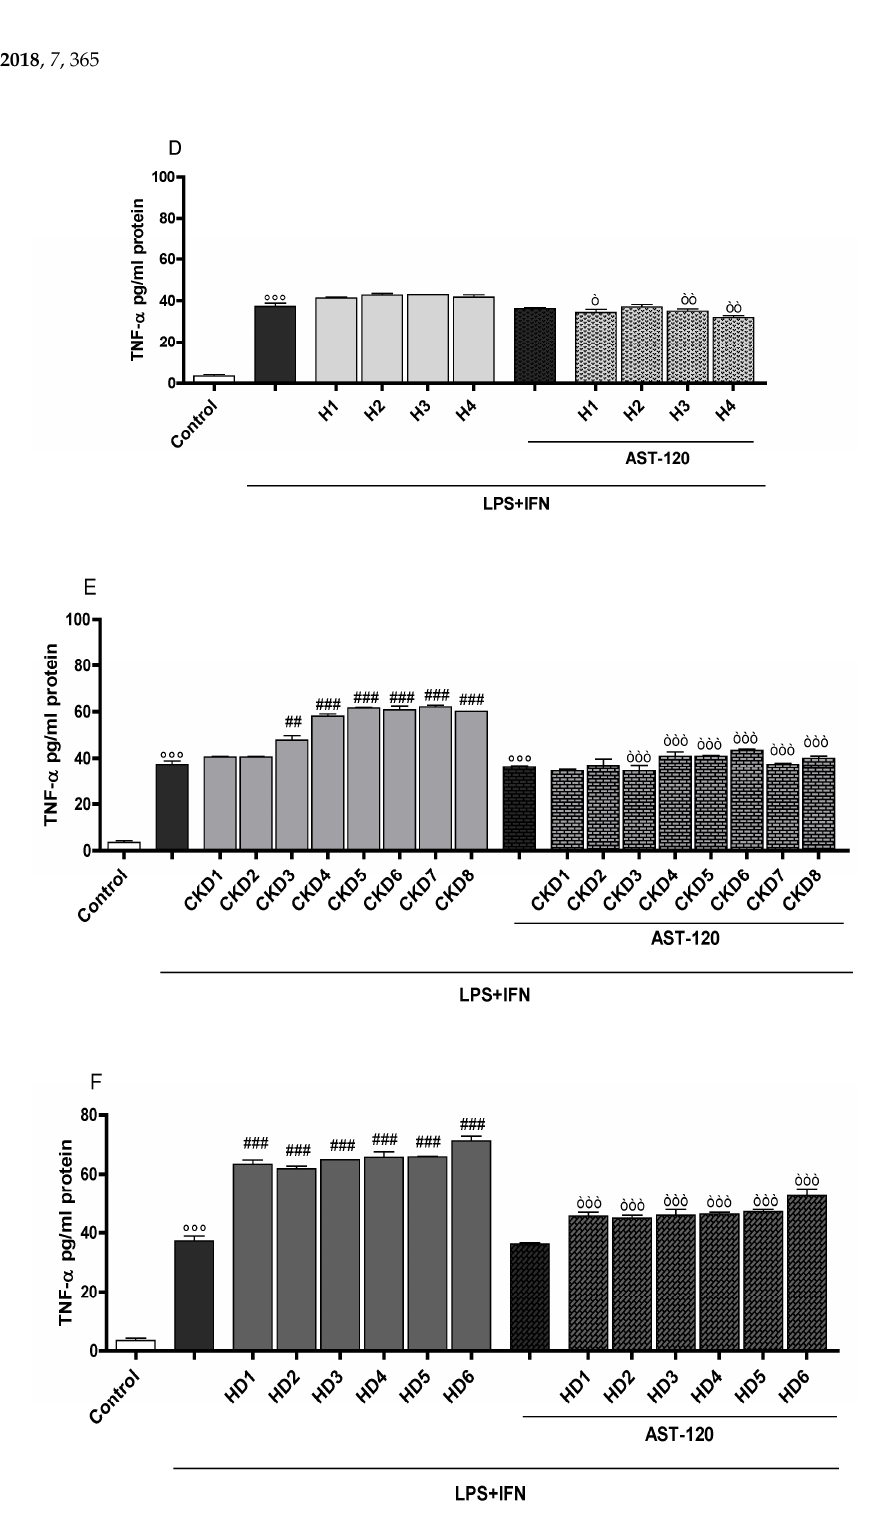
Figure 2. Effect of sera from eighteen different subjects: four healthy people (H1–H4; Panel A and D ), eight CKD patients (CKD1–CKD8; Panel B and E ) and six CKD dialysed patients (HD1–HD6; Panel C and F ), with or without AST-120, on nitrite ( Panel A – C ) and on TNF- α ( Panel D – F ) production in inflammatory conditions, induced by LPS (1 µg/mL) and IFN (100 U/mL) in C6 cells. Values are expressed as [ µ M] NO 2 − release, or as pg/mL protein, respectively. Comparisons were performed using a one-way analysis of variance and multiple comparisons were made by Bonferroni’s test. °°° denotes p < 0.001 vs. control. ###, ##, # denote p < 0.001, p < 0.01, p < 0.05 vs. LPS + IFN. Òòò , òò , ò denote p < 0.001, p < 0.01, p < 0.05 vs. serum + LPS + IFN.